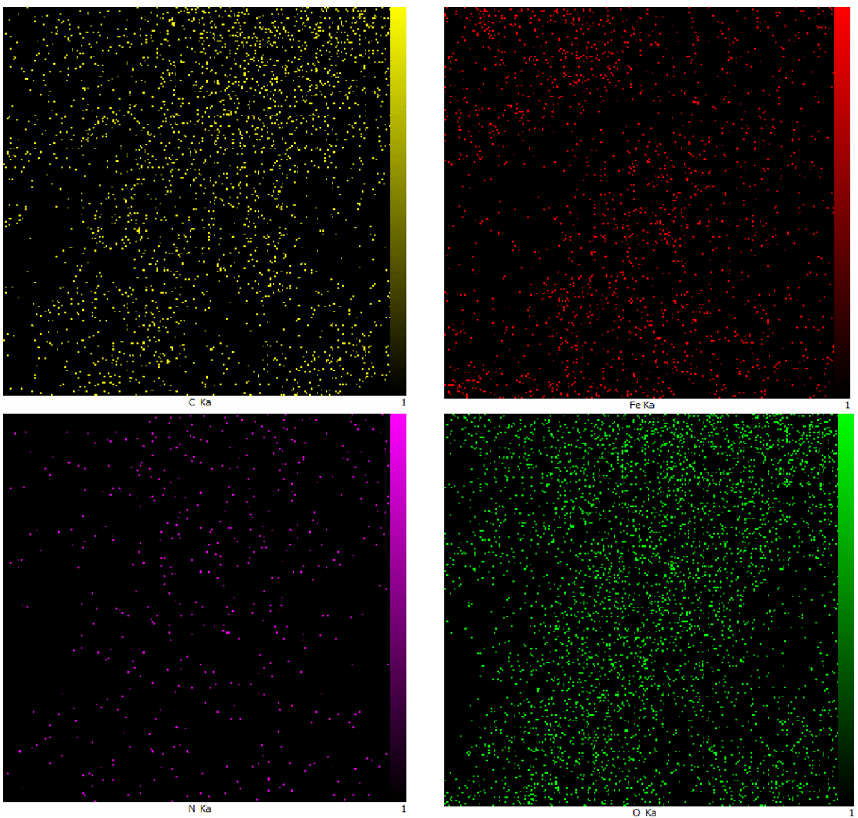
Figure 7. EDAX Mapping of Pip@MGO